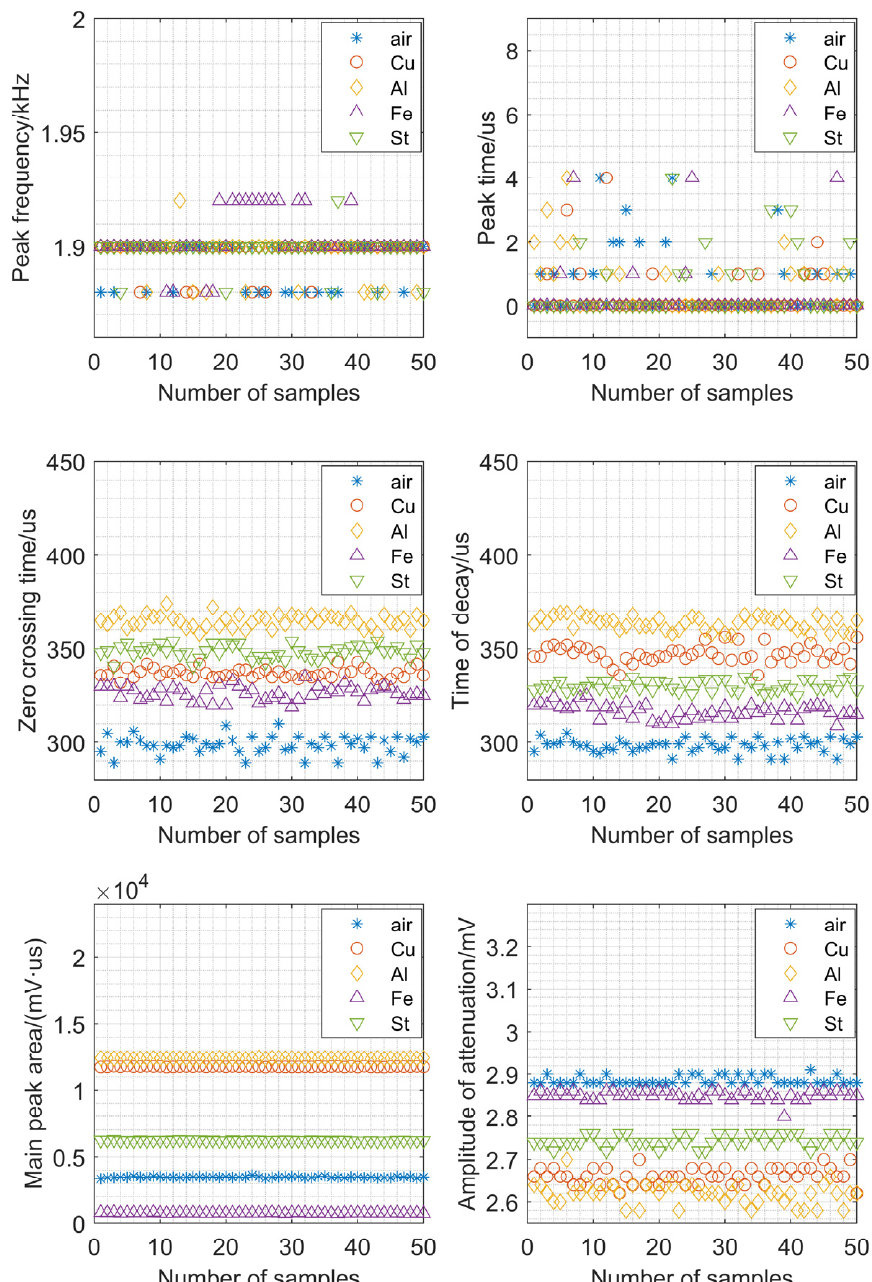
Figure 6. Signal characteristic distribution of air, Cu, Fe, Al and St.